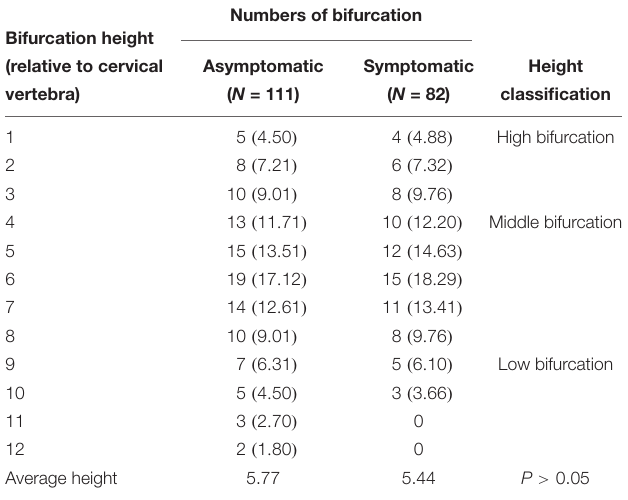
TABLE 3 | Distribution of carotid bifurcation height and height classification.